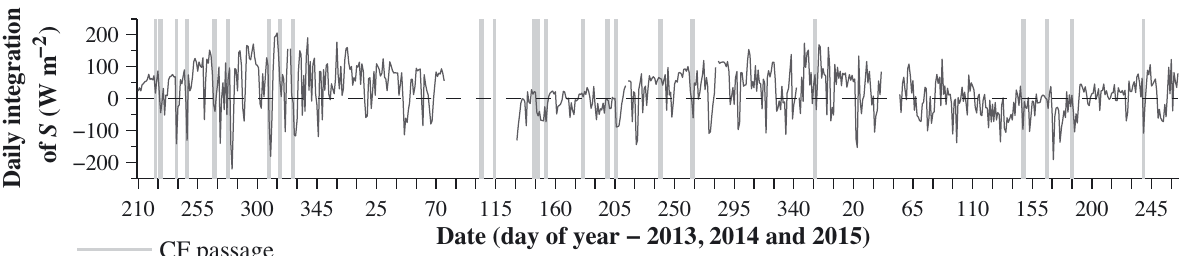
Fig. 5. Daily integration of surface heat flux balance ( S) at Furnas Hydroelectric Reservoir from July 2013 to September 2015. CF: cold